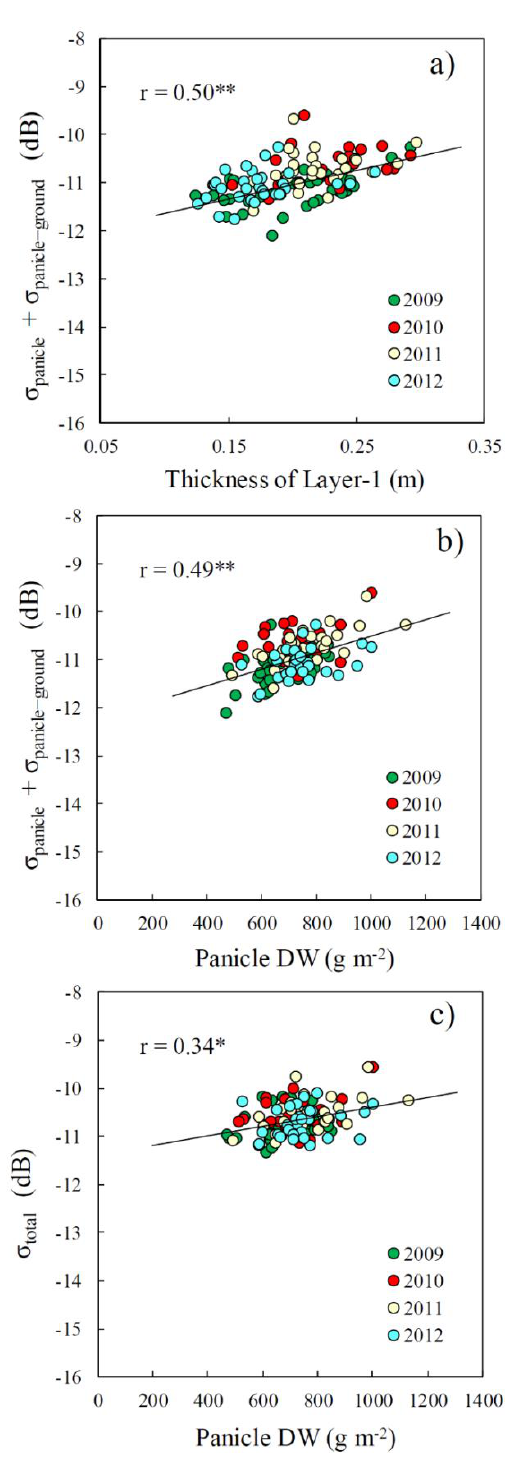
Figure 9. Simulated response of X-VV σ 0 at an incidence angle of 52° to a measured panicle variables. The sum of σ 0 components related to scattering of panicle is plotted against the measured layer thickness of panicle layer ( a ) and the panicle DW ( b ); respectively. The total canopy σ 0 is plotted against panicle DW in ( c ). * and ** indicate the statistical significance at 0.05 and 0.01,